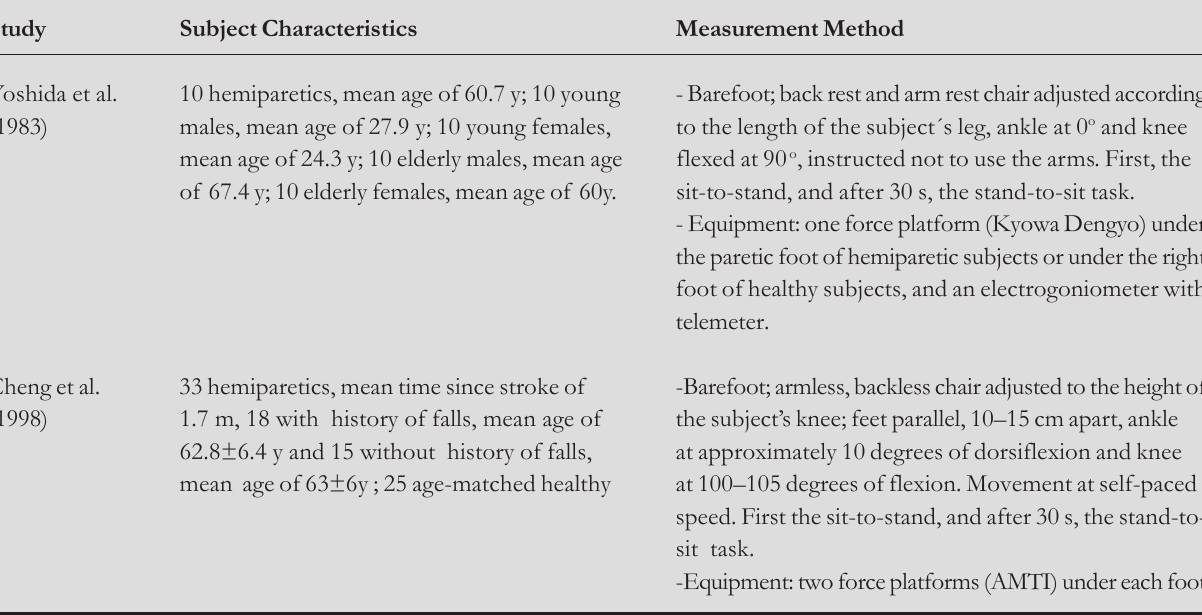
Table 2 - Description of observational research on sit-to-stand and stand-to-sit tasks with stroke subjects